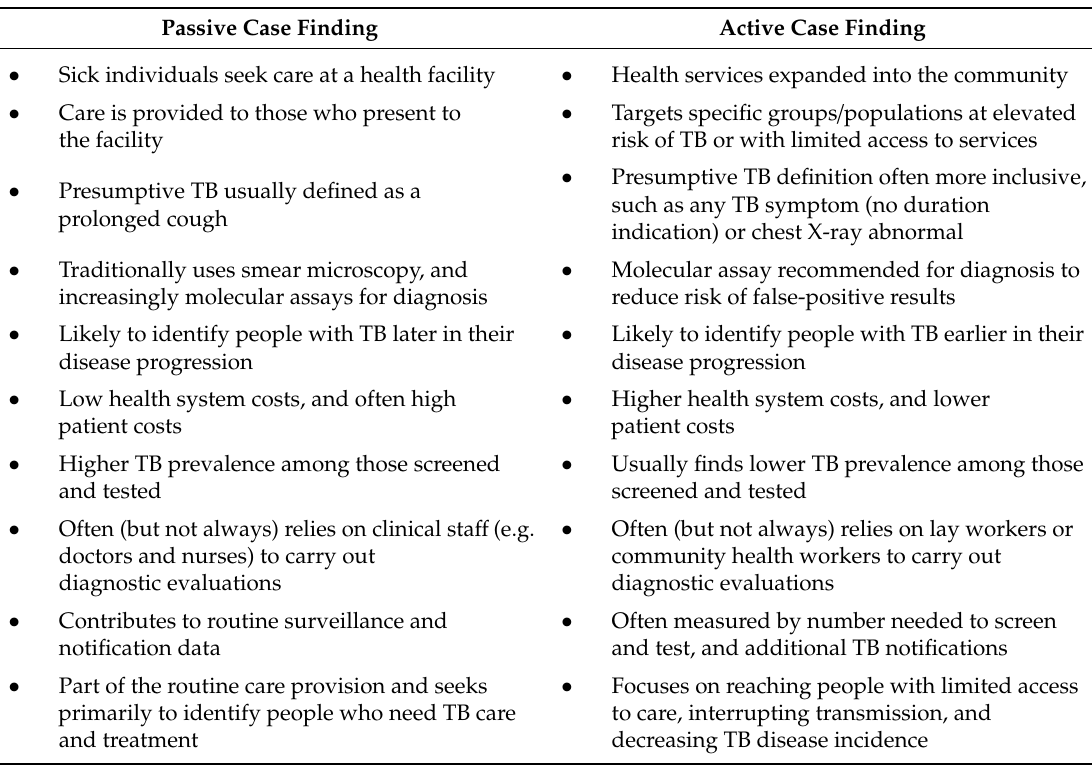
Table 1. Characteristics of Passive and Active Case Finding for